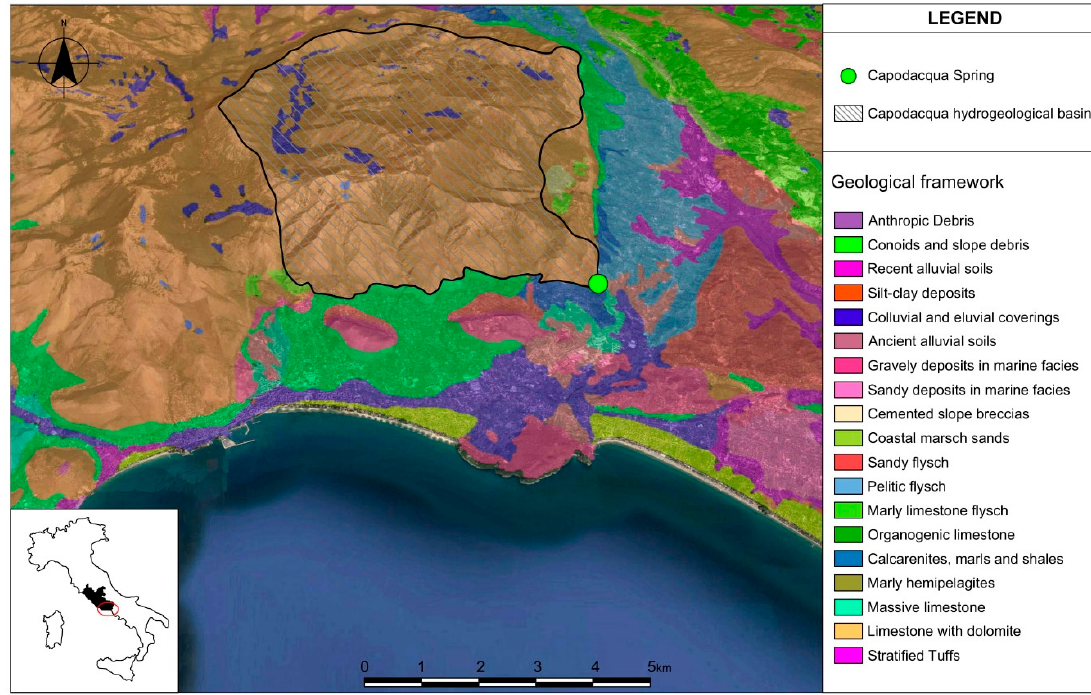
Figure 2. Geological framework of the study area.